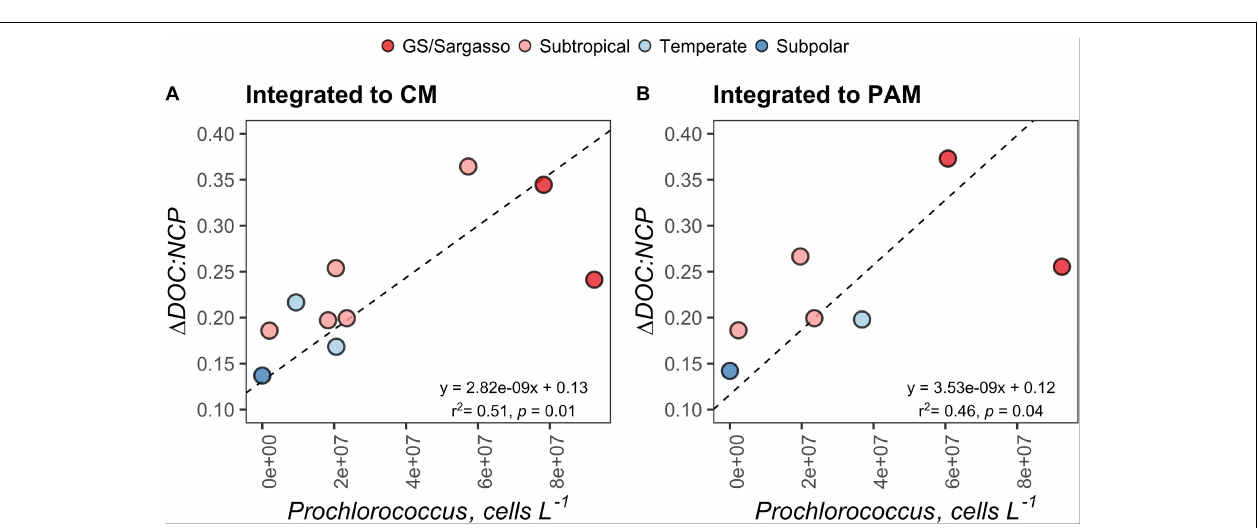
FIGURE 8 | Standard major axis model II regressions comparing the (cid:49) DOC:NCP ratio with the absolute abundance Prochlorococcus , integrated to the chlorophyll maximum ( CM ) (A) and the phytoplankton abundance maximum ( PAM ) (B) for each station. Each point represents estimates for a station on the early autumn cruise. Points are filled by the subregional classification of the station as presented in Figure 1